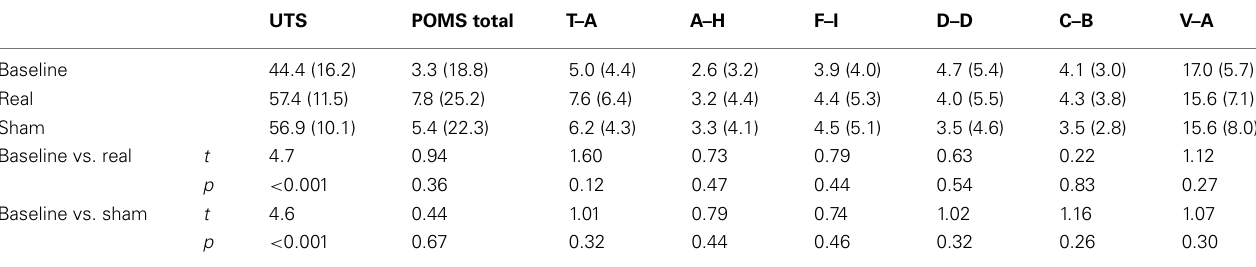
Table 1 | UTS and POMS scores at baseline and before tDCS at each session.